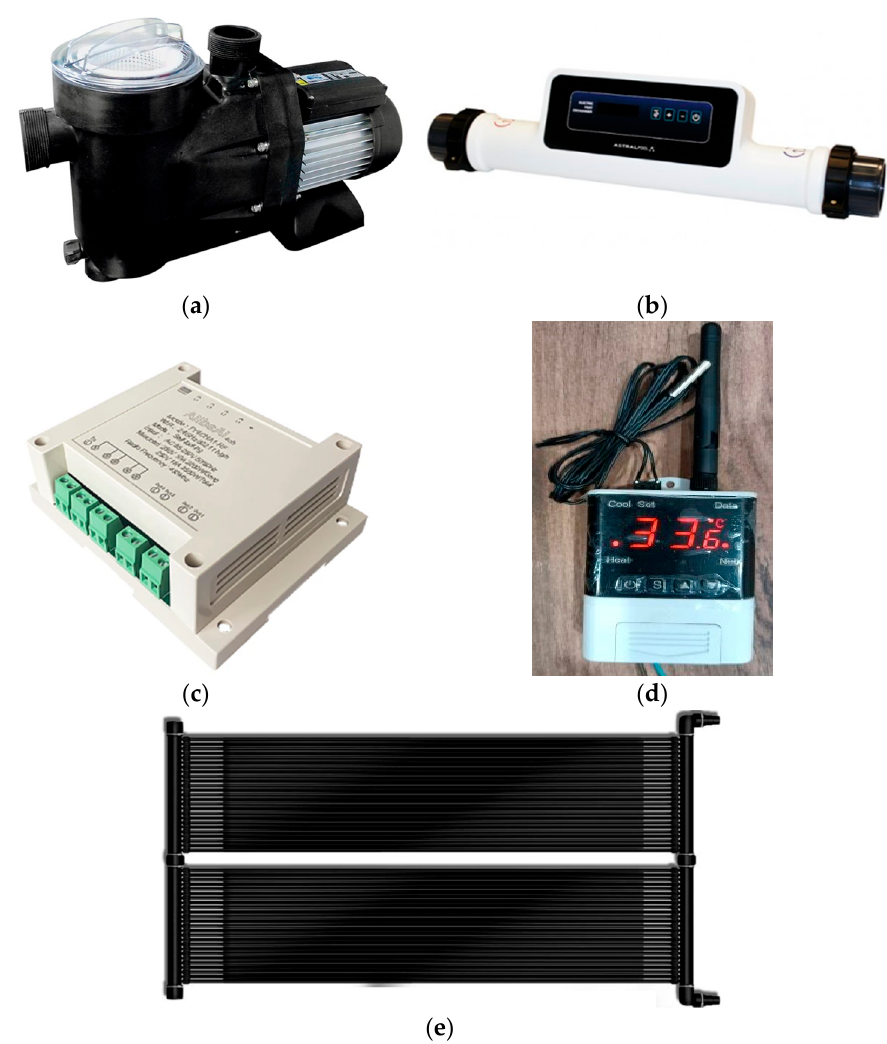
Figure 3. Devices used ( a ) Hydraulic pumps. ( b ) Electric heater. ( c ) 4-channel relay. ( d ) Smart temperature sensor. ( e ) Solar collector.